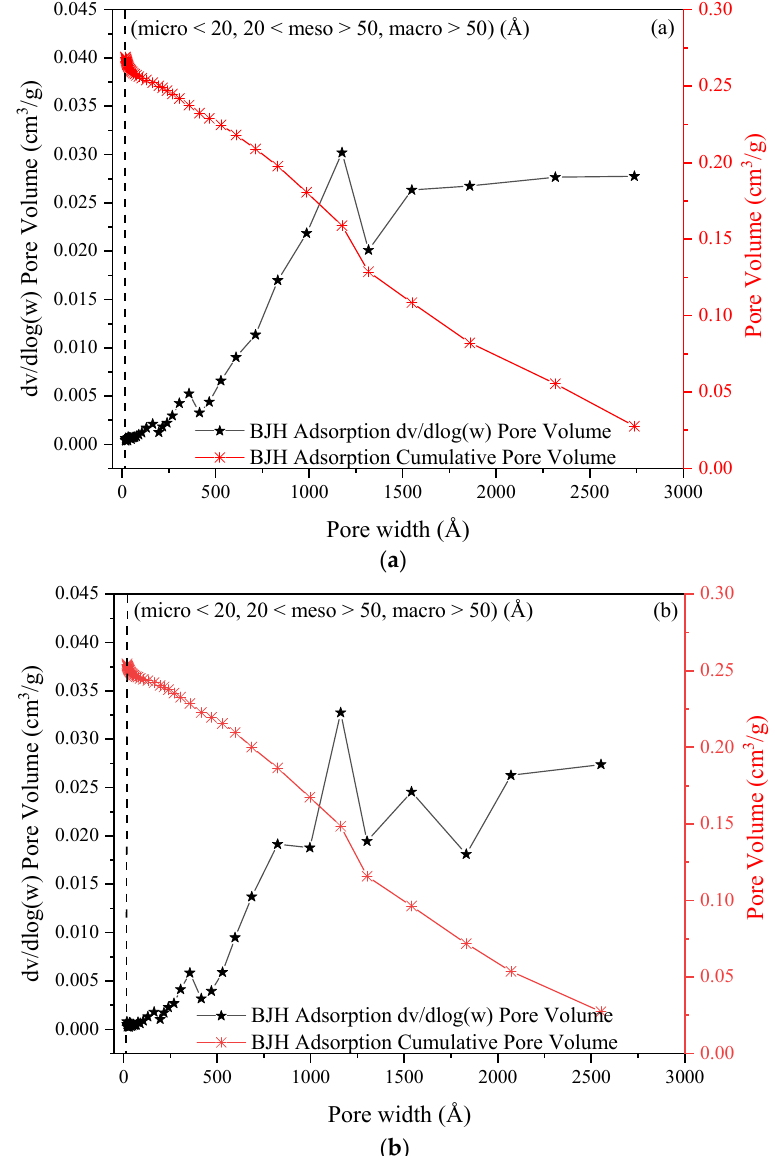
Figure 8. BJH adsorption pore volume of H + Dowex-M4195 chelating resin: ( a ) before ion exchange and ( b ) after ion exchange process.